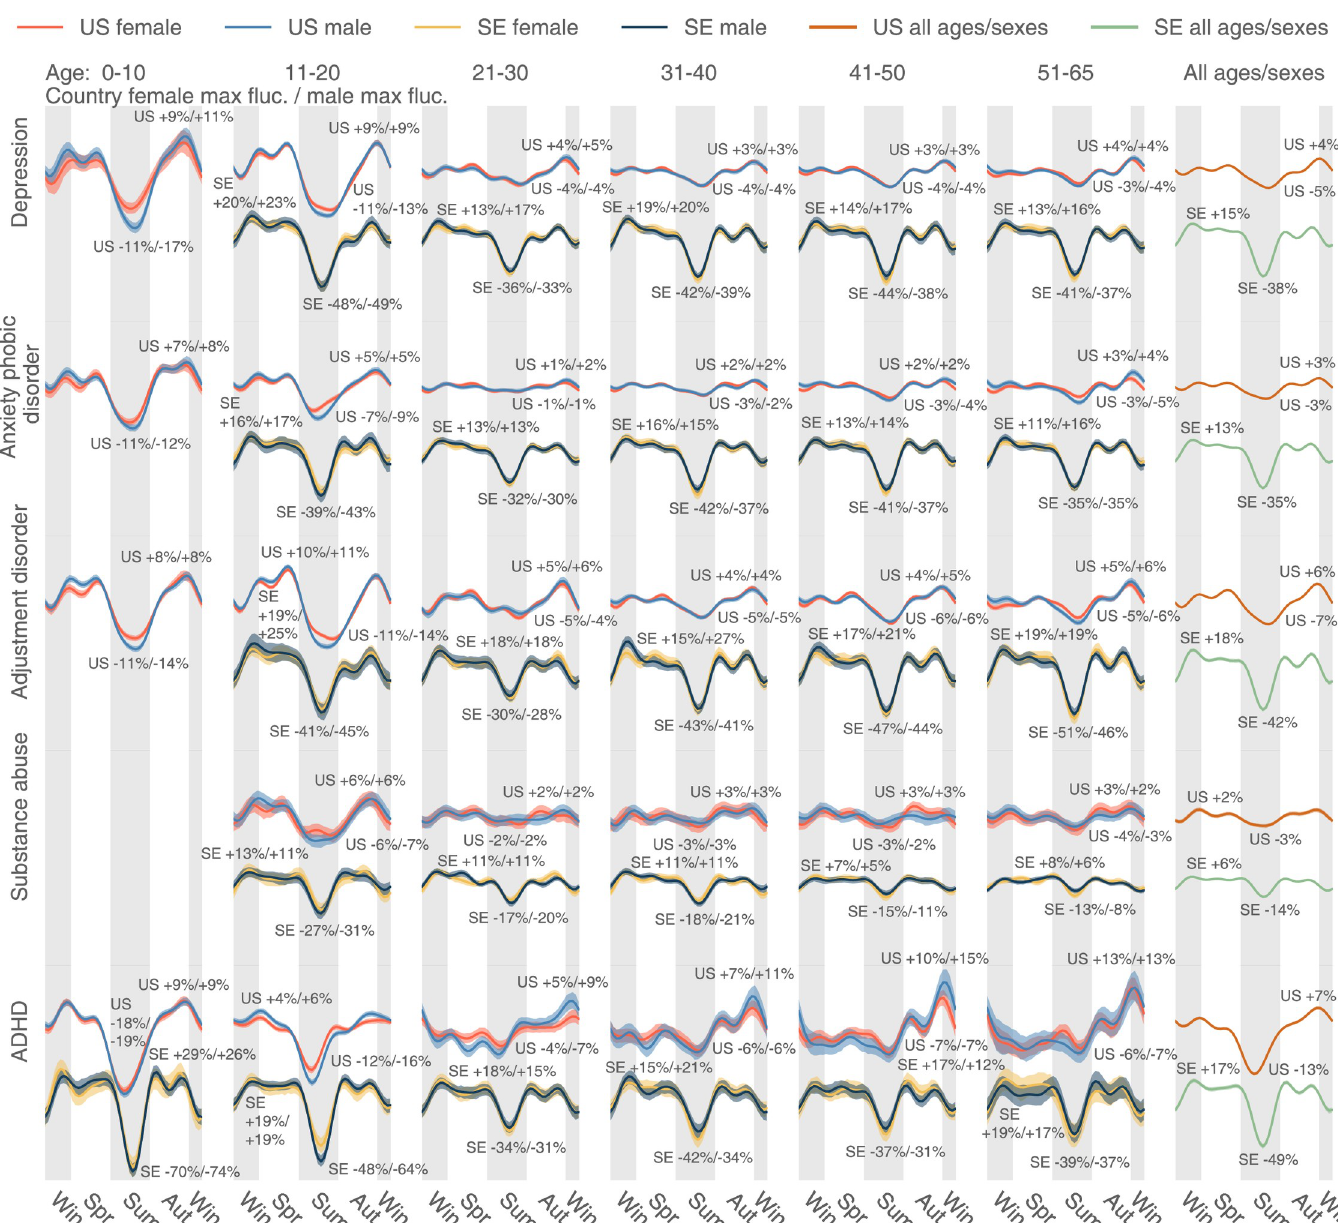
Fig 3. The uncorrected seasonality plots of the 5 most diagnosed psychiatric diseases in the US: Depression, anxiety/phobic disorder, adjustment disorder, substance abuse, and ADHD. The results in SE are juxtaposed, but scaled by 0.3 in magnitude for clearer comparison. We plotted all lines based on a weekly DR estimated as the total number of diagnoses in a week, divided by the total number of enrollees in our database in the week. Positive and negative maximum fluctuations compared to the mean DR are text-labeled following a format: Country female maximum fluctuation in percentage / Male max fluctuation in percentage. We use the meteorological seasons defined as follows: Winter starts from December 1 and ends on February 28, spring starts from March 1 and ends on May 31, summer starts from June 1 and ends on August 31, and autumn is the rest of the year. We discarded the health records of people over 65 because the majority of that population in the US data switched to Medicare, and remaining records were not representative. A disease could be extremely rare in some age–sex brackets. The plot only shows those age–sex– specific seasonalities with a time-average DR (Expression (17)) larger than 1 × 10 − 5 . The data underlying this figure can be found in https://doi.org/10.5061/dryad. vdncjsxv6. ADHD, attention-deficit/hyperactivity disorder; DR, diagnosis rate; SE, Sweden.